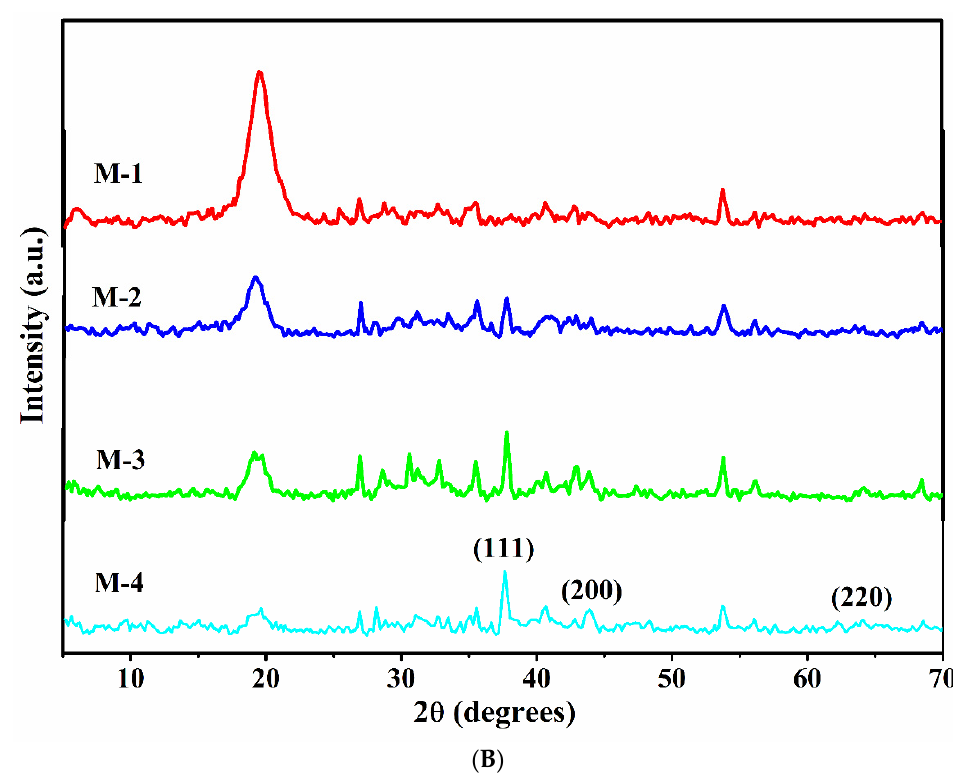
Figure 2. ( A ). Wide-angle X-ray diffraction patterns of plane PVA and Chitosan. ( B ). Wide-angle X-ray diffraction patterns of CS-capped AgNP-incorporated PVA membranes: (M-1) 0.5 wt.%; (M-2) 1 wt.%; (M-3) 1.5 wt.%; (M-4) 2 wt.% of CS-capped AgNPs.